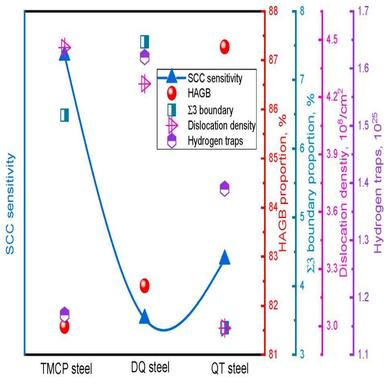
Relationship between the SCC sensitivity and influencing factors of different Ni-advanced steels.